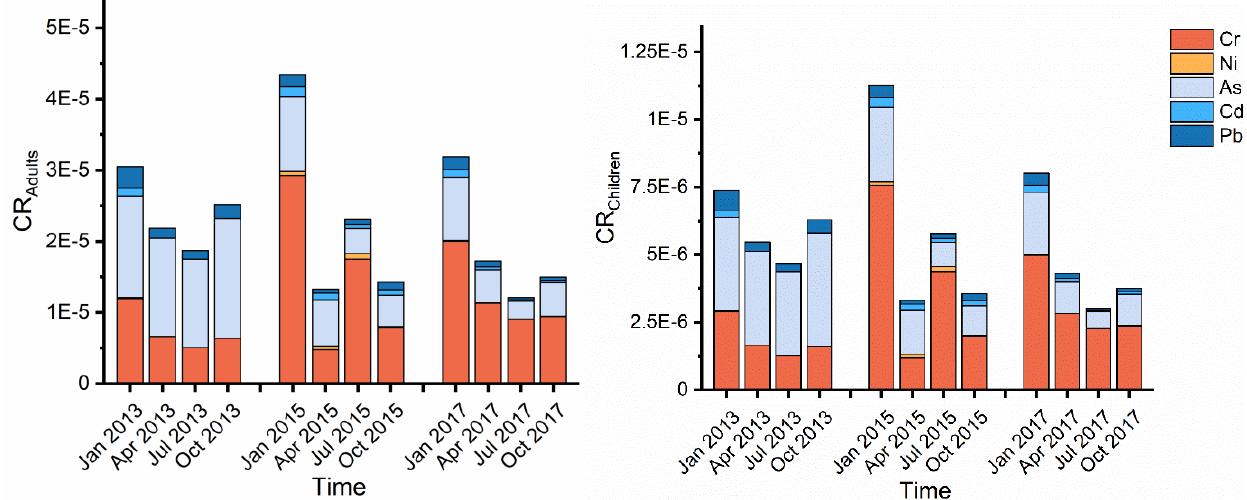
Figure 8. Monthly risk value of carcinogenic exposure by inhalation route (n Cr = 344, n Ni = 264, n As = 344, n Cd = 264 and n Pb = 344). Table 4. Carcinogenic risk of heavy metals in PM 2. 5 in different cities.